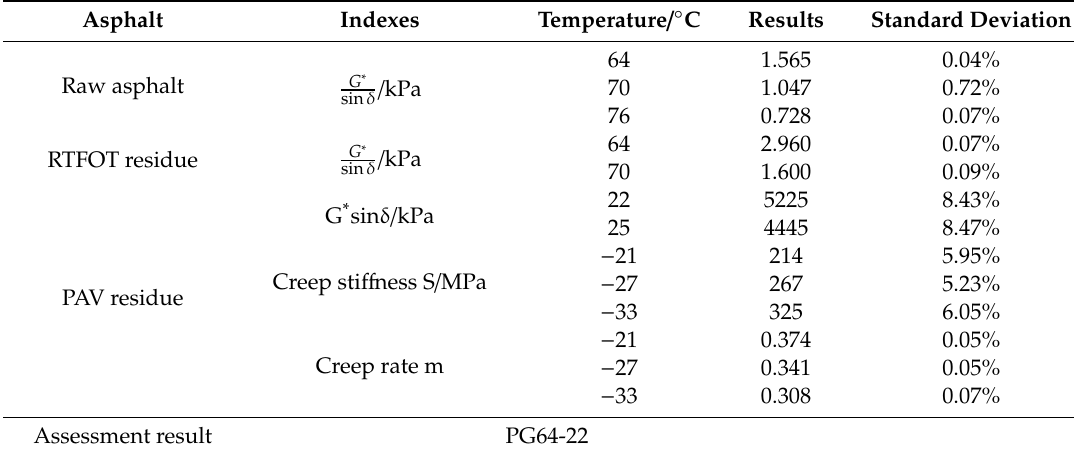
Table 7. PG grade results of SBSMA (SBS modified asphalt).